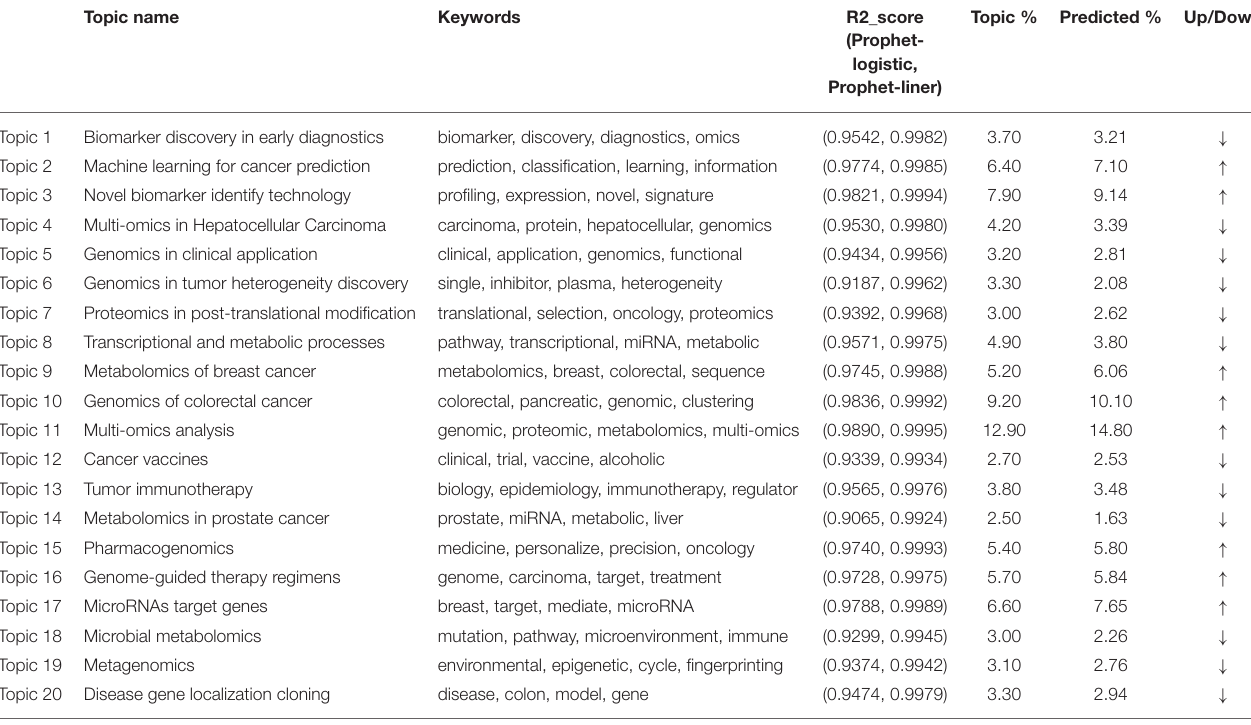
TABLE 1 | Results for topic extraction and topic